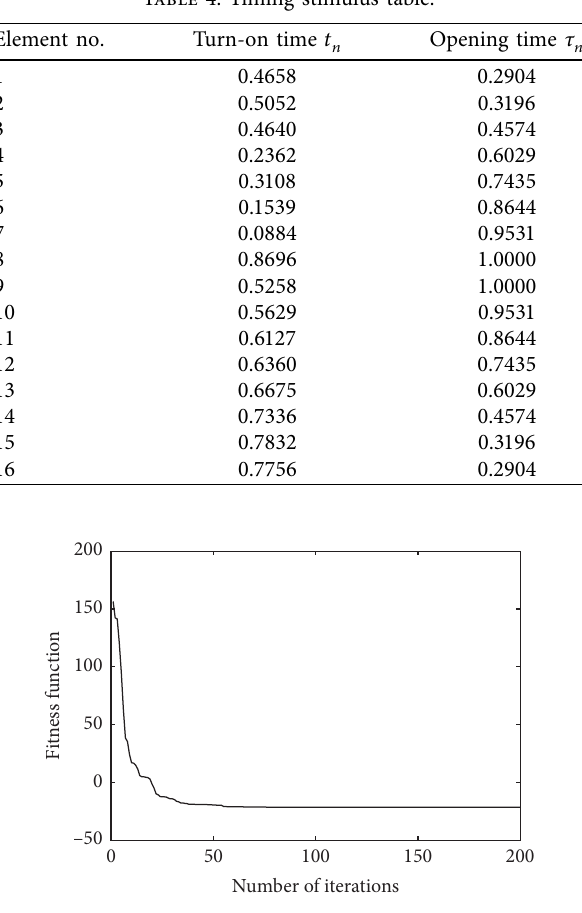
Figure 8: Fitness function convergence